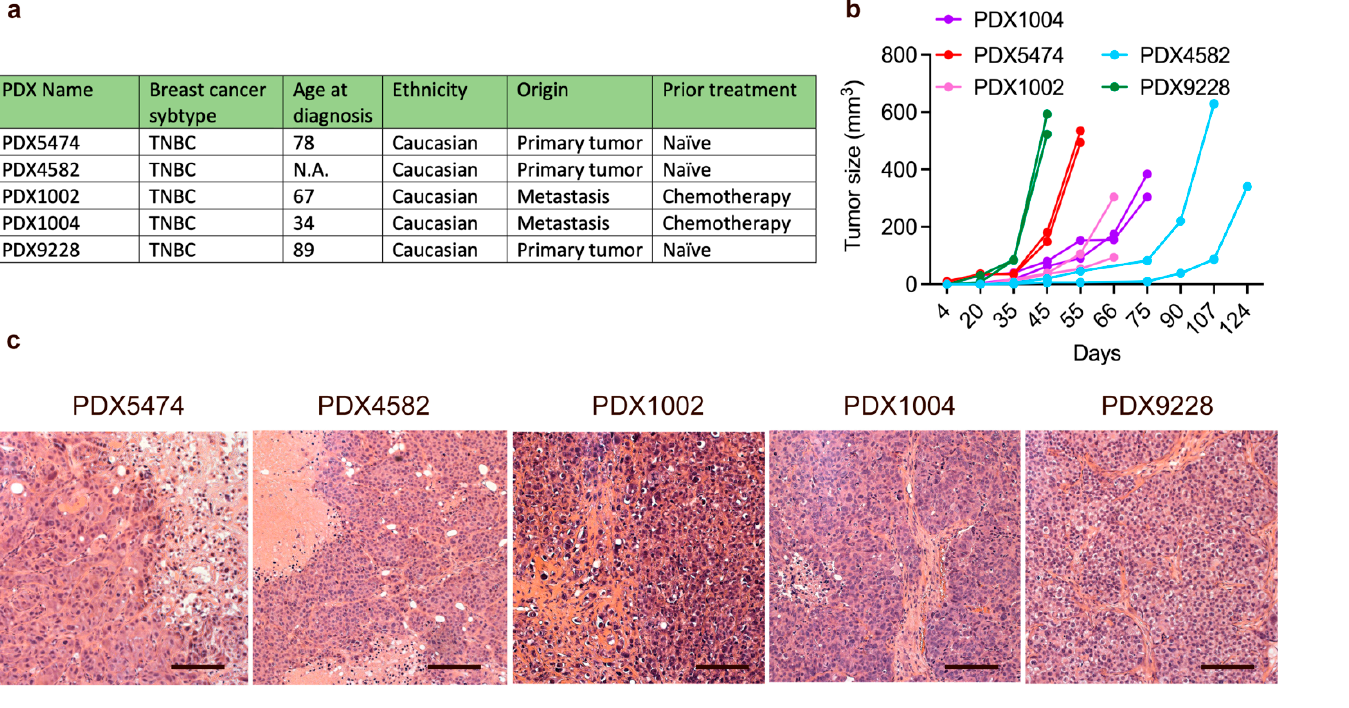
Figure 1. Characteristics of breast cancer PDX models. ( a ) Selected clinical parameters of the PDX models. ( b ) PDX tumor tissue was transplanted into the mammary fat pad of NOG mice, and PDX tumor growth was evaluated using caliper measurements. Each graph represents a single PDX tumor. ( c ) Hematoxylin and eosin (H and E) stainings of the breast cancer PDX models. Scalebars = 200 μ M. For the H and E stainings, the PDX tumor size and timepoint upon harvest are shown in Supplementary Table S1.